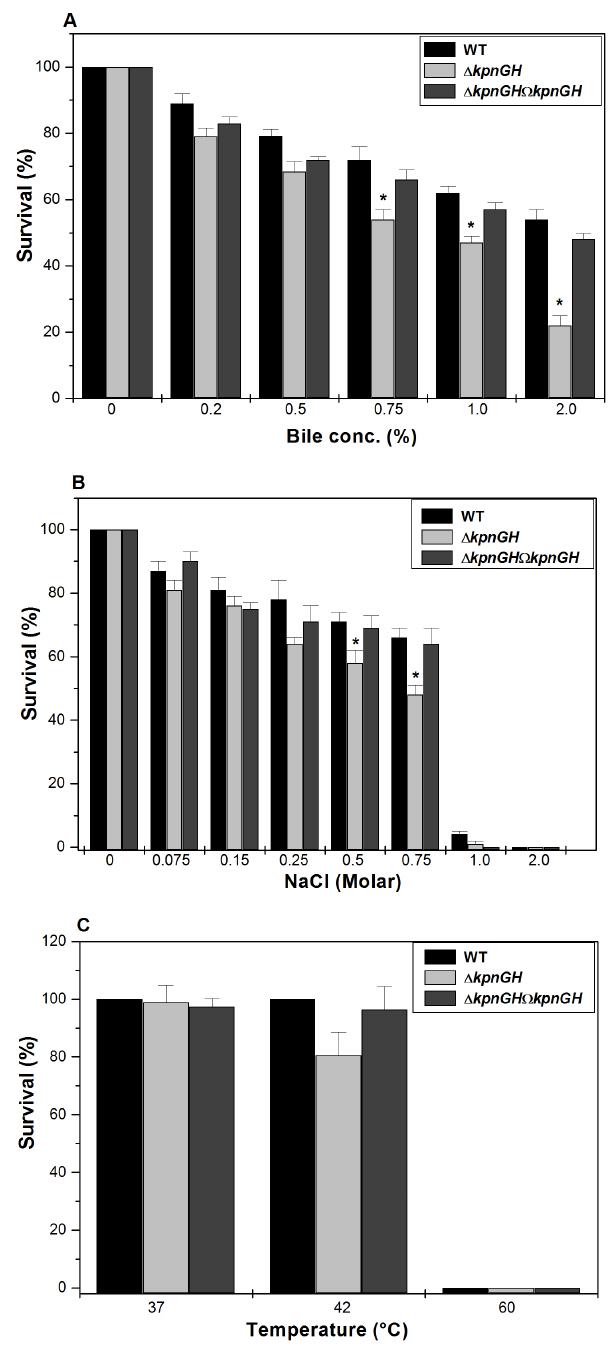
Figure 2. Gastrointestinal stress challenge assays. Survival of wild type, D kpnGH and D kpnGH V kpnGH in different concentrations of A) Bile (0.2%, 0.5%, 0.75%, 1.0%, and 2.0%), B) Osmotic stress (0.075M, 0.15M, 0.25M, 0.5M, 0.75M, 1M and 2M) and C) Different temperatures (37 u C, 42 u C and 60 u C). Percentage survival was calculated by comparing the number of viable cells in LB medium alone. *, Significant difference (P , 0.05, Student t test).